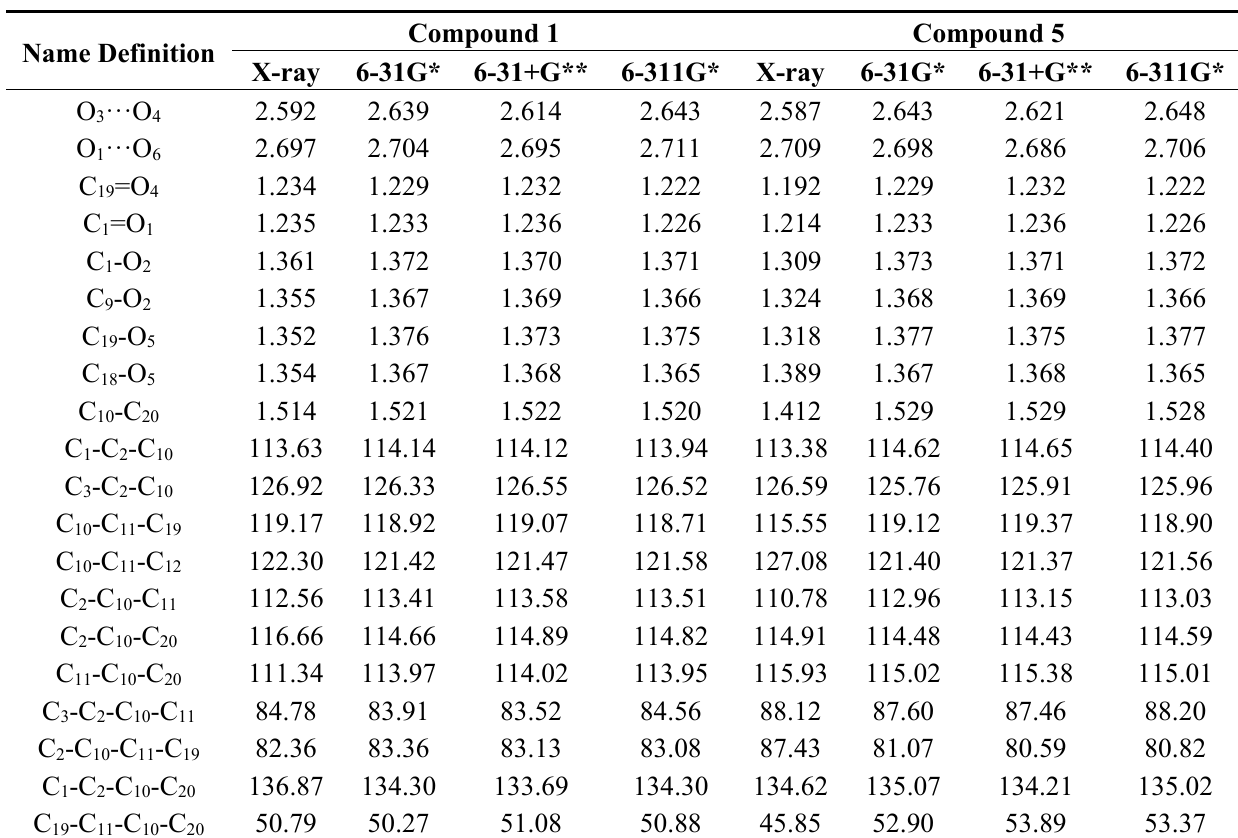
Table 1. Experimental and calculated parameters of the selected bond lengths and bond angles of compounds 1 and 5